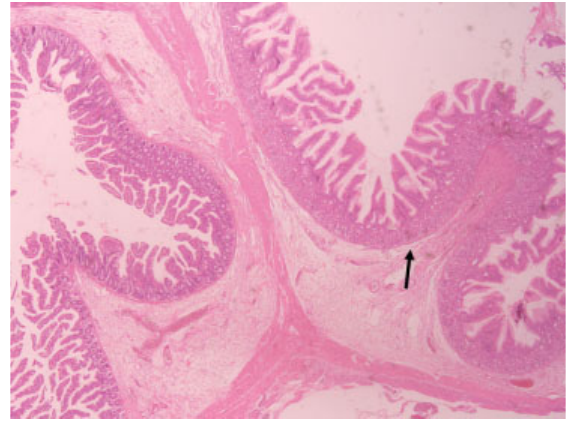
Fig. 3 Intestinal duplication cyst with ectopic gastric mucosa (Black arrow).